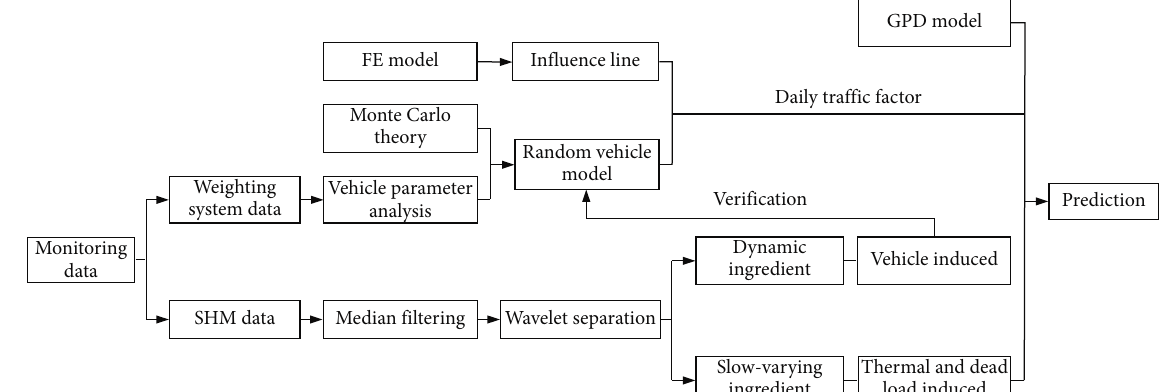
Figure 1: The flowchart of the method.